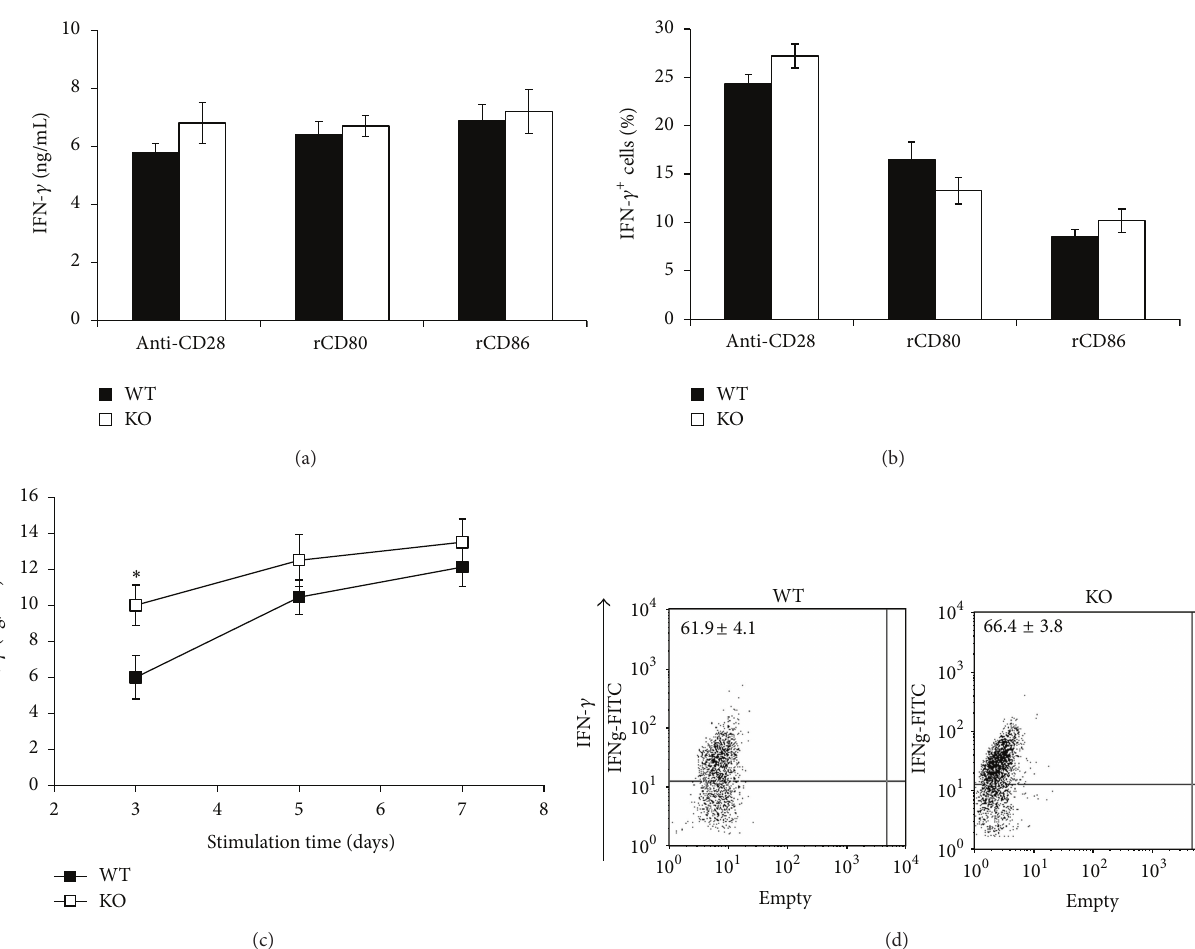
Figure 3: PARP-1 deficiency does not affect Th1 cell polarization. Na¨ıve CD4 T cells from wild type (WT, filled symbols) and PARP-1KO (KO, unfilled symbols) mice were stimulated with anti-CD3 mAb and either anti-CD28 mAb or rCD80 or rCD86 for 7 days, ((a), (b), and (d)), or for the indicated time points (c). (a) and (c) IFN- 𝛾 concentration in culture supernatants as assessed by ELISA. (b) Cells were collected, restimulated with PMA and ionomycin for 6 hours in the presence of brefeldin A and analyzed by flow cytometry to assess the frequency of IFN- 𝛾 -producing cells. (c) IFN- 𝛾 concentration in cell cultures stimulated with anti-CD3, anti-CD28, IL-12, and neutralizing anti-IL-4 mAb (Th1-polarizing conditions). (d) Cells were stimulated under Th1-polarizing conditions for 7 days and, after restimulation as in (b), analyzed by flow cytometry. Values represent means ± S.E. ∗ 𝑃 < 0.05 for KO versus WT cells. Results were confirmed in three other independent